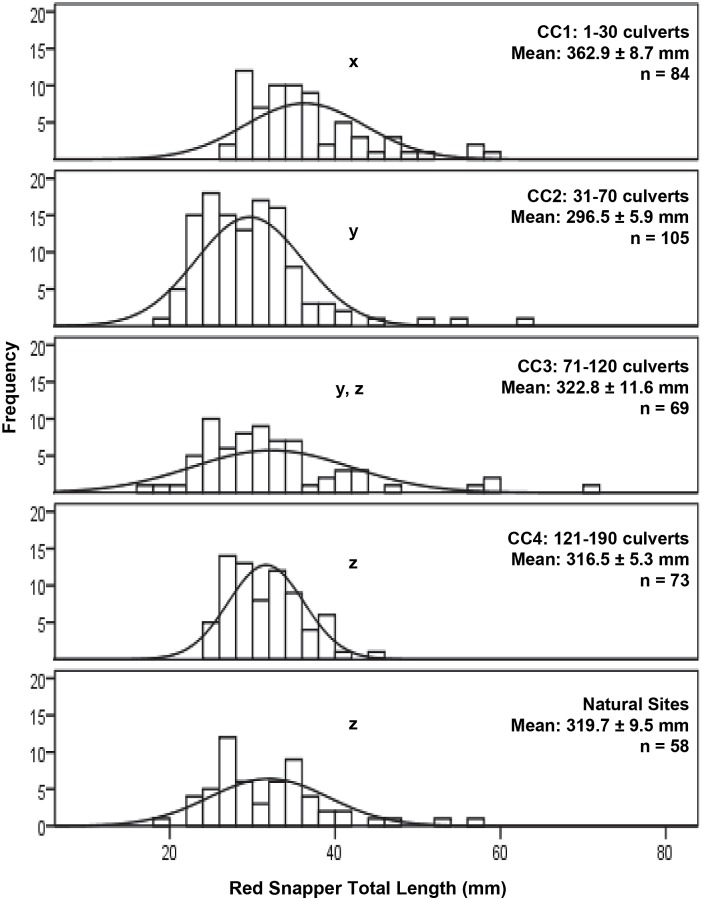
Frequency distributions of Lutjanus campechanus total lengths among reef categories in 2014.Non-matching lower case letters indicate reef categories that are significantly different from one another (P > 0.05). Curves represent overall pattern of each frequency distribution.